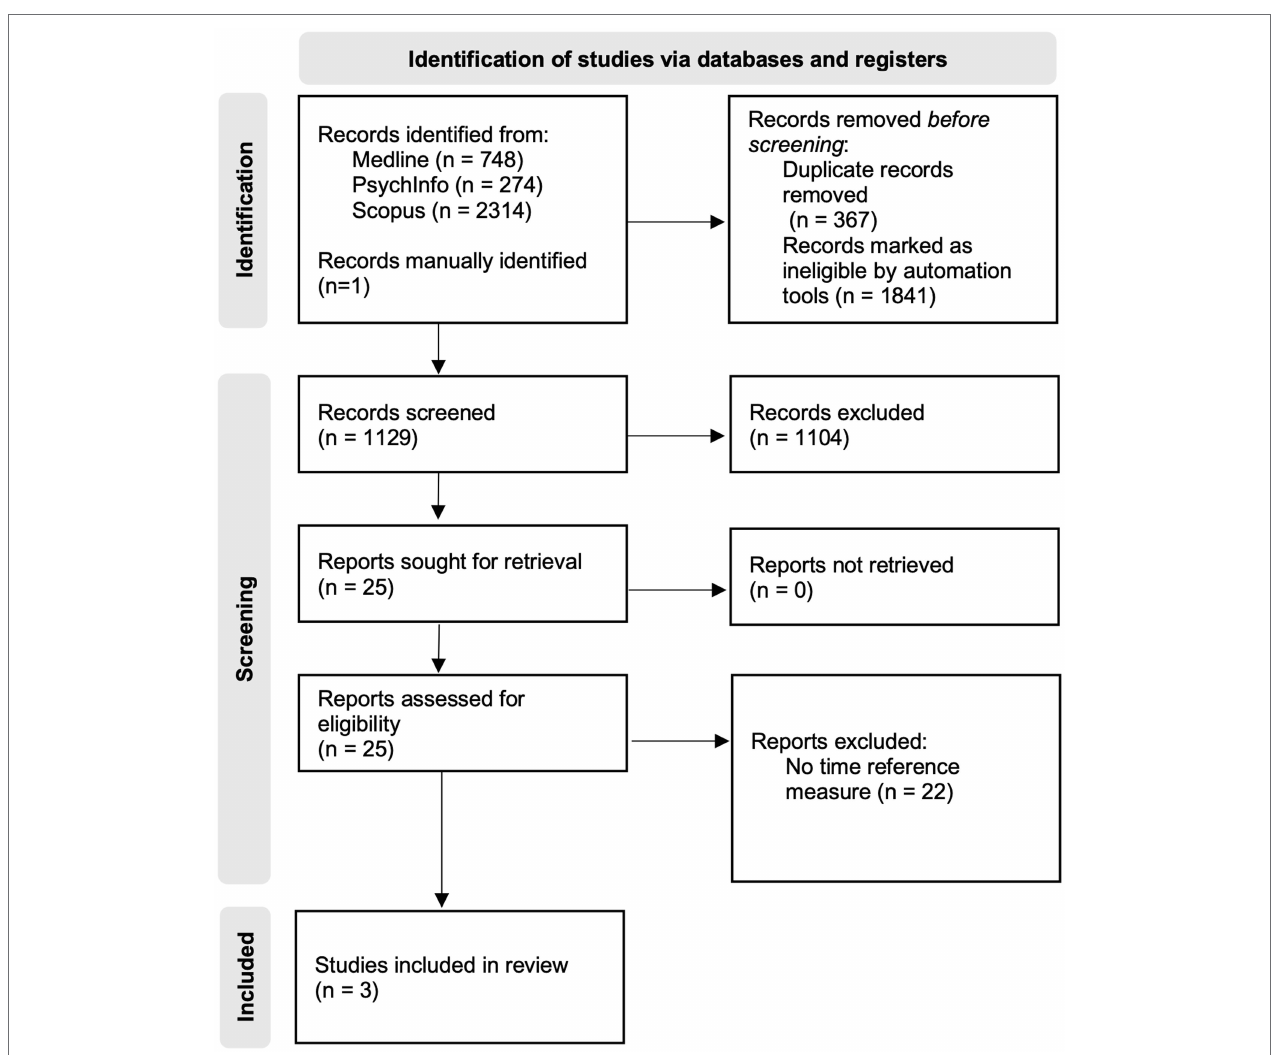
FIGURE 1 | Flow diagram of the identification and selection of records, adapted from the Preferred Reporting Items for Systematic Reviews and Meta-Analysis (PRISMA) flow diagram (Page et al.,